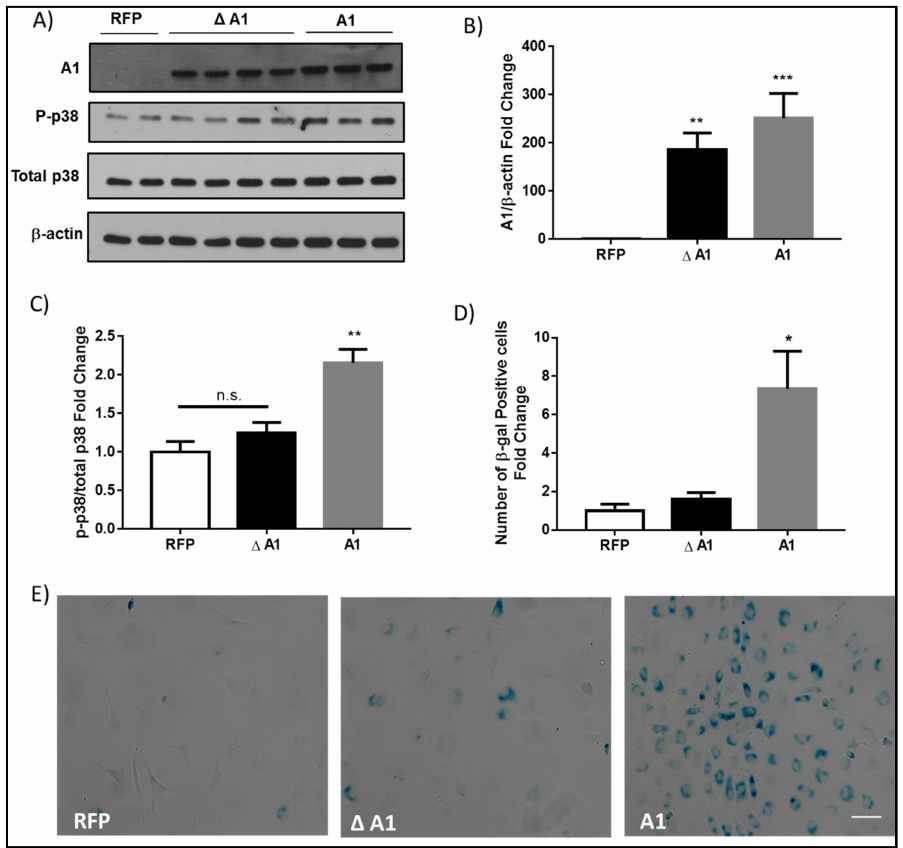
Figure 8. Arginase 1 (A1) overexpression induces endothelial cell senescence. ( A ) Western blot analysis with quantification ( B ) showing levels of A1 protein or ( C ) phosphorylation of the stress marker p38 in bovine retinal endothelial cells (BRECs) transduced with 20 MOI of wild type A1 (A1), inactive mutant A1 ( ∆ A1), or red fluorescence protein (RFP) adenovirus vectors. The inactive mutant A1 was generated by mutation of aspartic acid 128 to glycine. ( B ) ** p < 0.01 vs. RFP. *** p < 0.001 vs. RFP. n = 6–8. ( C ) n.s., non-significant, ** p < 0.01 vs. RFP & ∆ A1. n = 3–8. Experiments were repeated at least twice in independent batches of cells. Data are presented as a fold change of RFP; ( E ) Senescence associated β -galactosidase (SA β -Gal) activity with quantification ( D ) showing a significant increase in SA β -Gal positive cells with A1 overexpression as compared to RFP or the inactive mutant A1 ( ∆ A1). * p < 0.05 vs. RFP & ∆ A1. n = 5–10. Experiments were repeated at least twice in independent batches of cells. Data are presented as a fold change of RFP. Scale bar = 50 µ